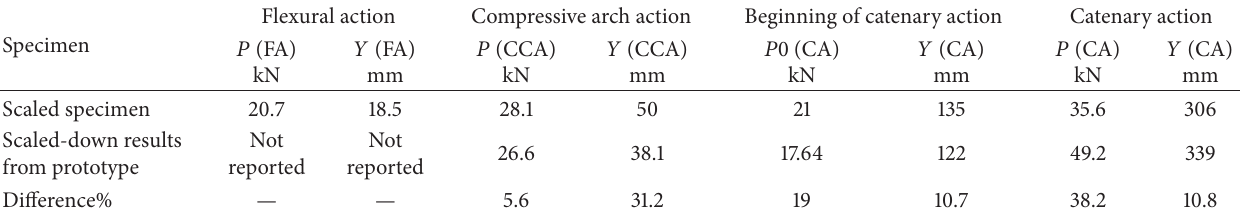
Table 2: Comparison of force and displacement at critical points of scaled specimen and scale-down results of prototype. Flexural action Specimen Scaled specimen Scaled-down results from prototype